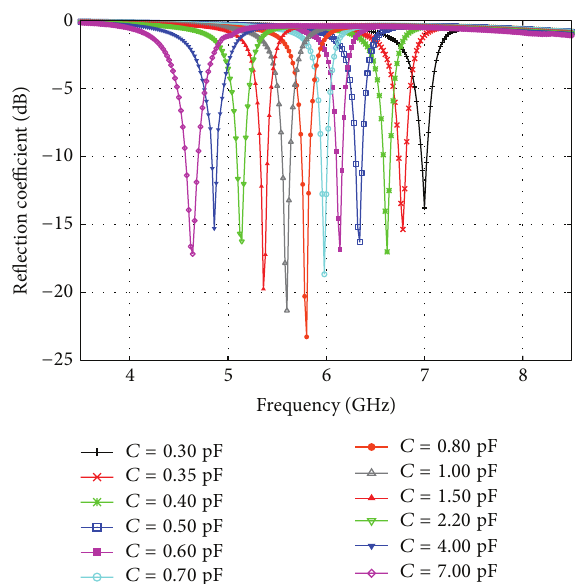
Figure 11: Reflection coefficient of the filtenna in Figure 10 for the indicated varactor capacitance